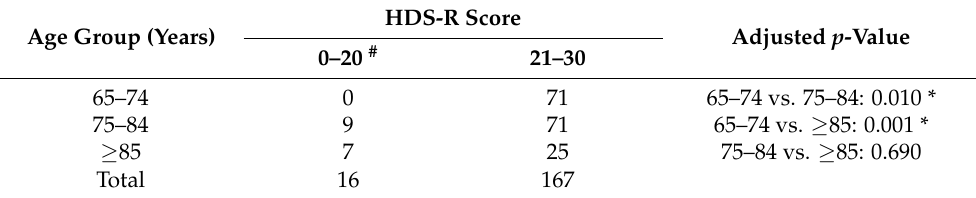
Table 2. Di ff erences in total score on the HDS-R according to age group. Table 2. Differences in total score on the HDS-R according to age